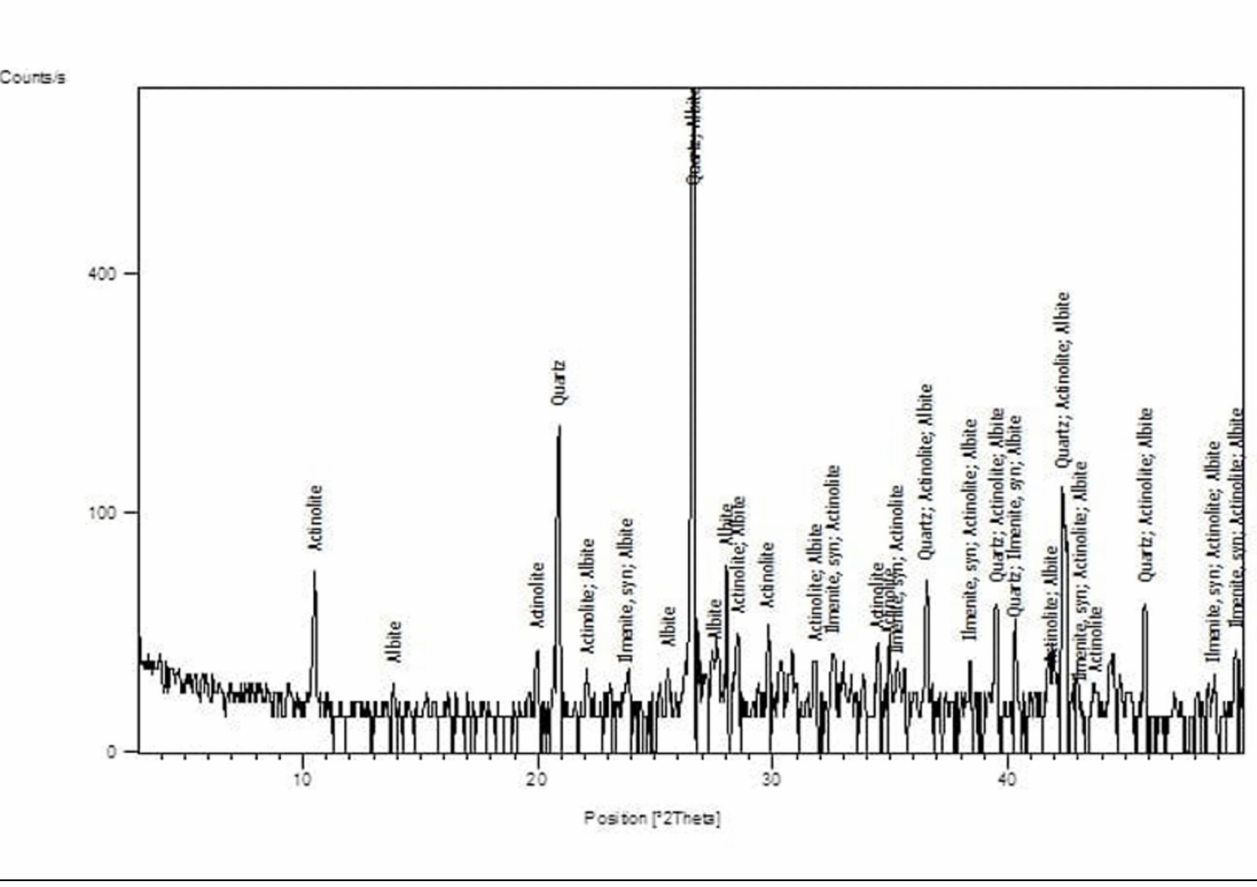
Figure 3. Black sand XRD analysis [41].